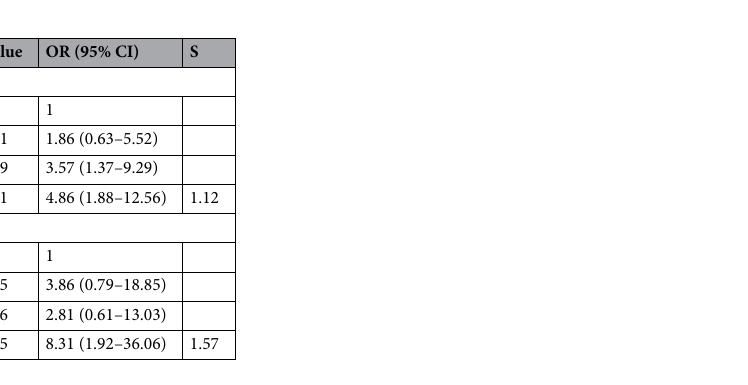
Table 4. Interaction of genetic factor with diabetes mellitus and obesity on advanced fibrosis. CI confidence interval, OR odds ratio, DM diabetes mellitus, S Synergy Index.